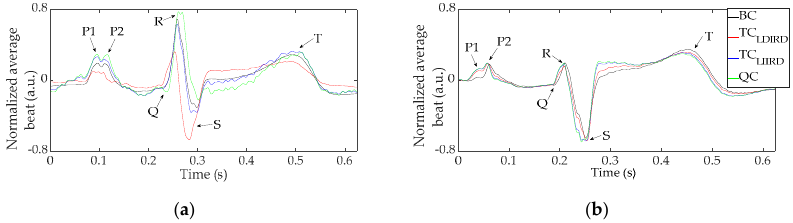
Figure 3. Normalized average beat of the Laplacian estimates via CRE at position CMV1: ( a ) from a volunteer with CV_NAP = 35.0%, ( b ) from a volunteer with CV_NAP = 4.3%. BC: bipolar configuration; TC: tripolar configurations; QC: quadripolar configuration.